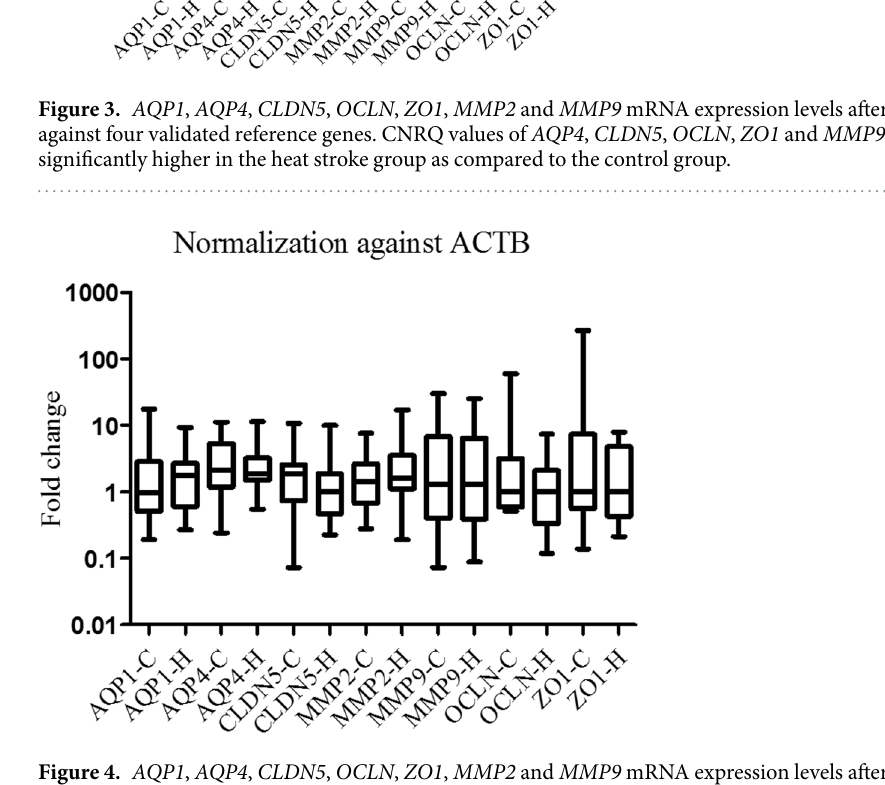
Figure 4. AQP1 , AQP4 , CLDN5 , OCLN , ZO1 , MMP2 and MMP9 mRNA expression levels after normalization against ACTB . There was no significant difference in the expression of any target